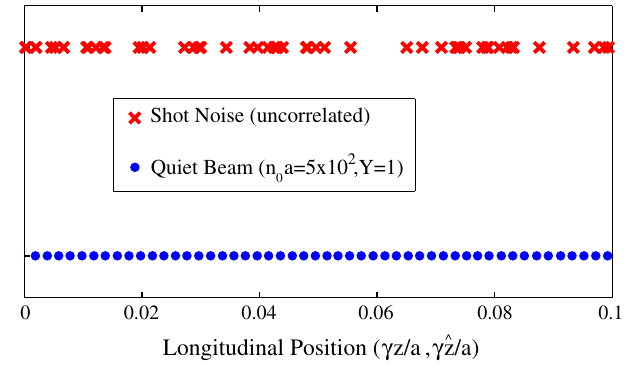
FIG. 5. Longitudinal distribution of particles in simulation before ( (cid:8) ) and after ( (cid:10) ) the noise suppression process. For =R n (cid:2) and a 1D beam, it is possible to show that the (cid:1) (cid:9) 1 56 0 initially uncorrelated distribution gives way to a regularly spaced beam with interparticle spacing 1 =n regular structure amplifies bunching at very high frequencies k ¼ 2 (cid:3)n and its harmonics, while suppressing F ð k Þ at frequen- 0 . 1 In Eq. (2) of Ref. [17], the Bessel function should be K , not K cies below 2 (cid:3)n 0 1 0